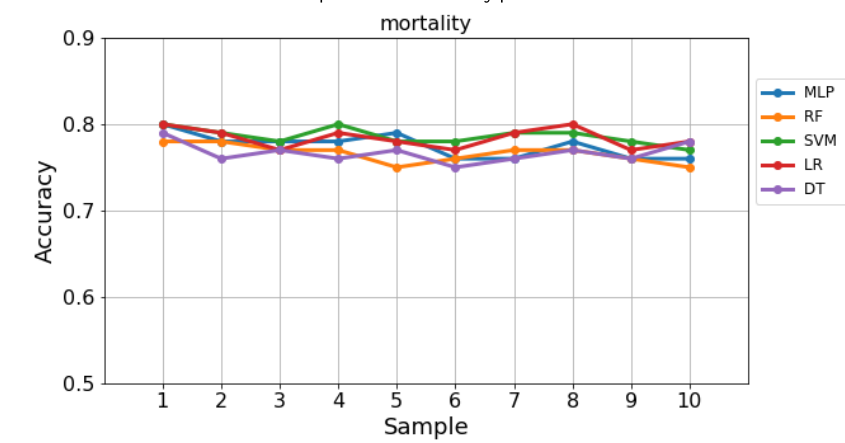
Figure 5. The score of five models across 10 validation samples on the mortality problem.